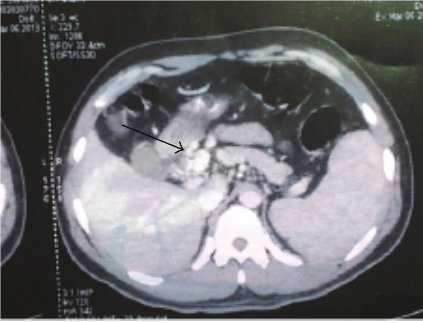
Figure 2: CT angiogram showing a coronal view of multiple collaterals (arrow) with poorly localized portal